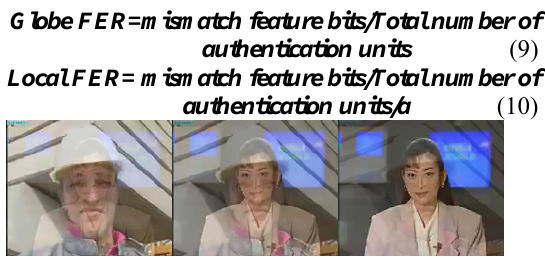
Figure 9. Foreman-Akiyo Superimposing attack using a merge factor (from left to right 0.2, 0.5, 0.8)